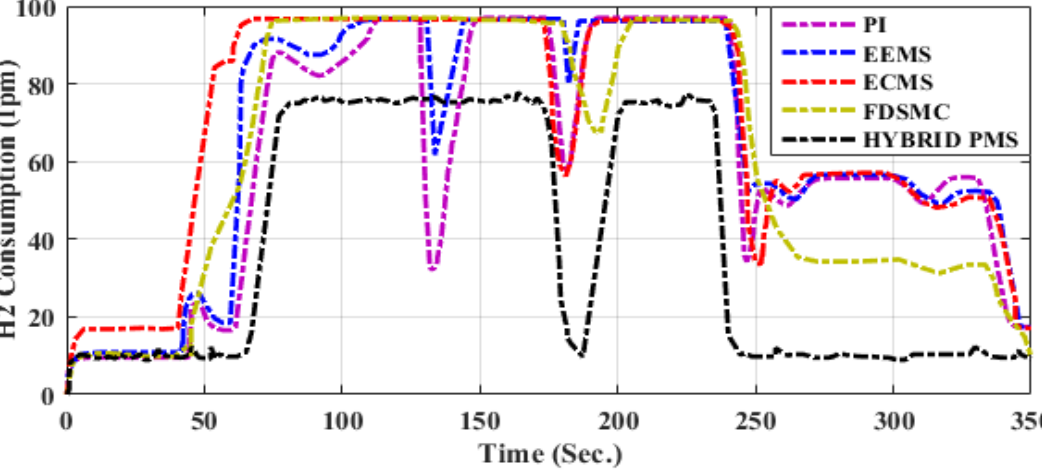
Figure 14. Hydrogen consumption in grams for studied approaches (HWFET — Drive Cycle).